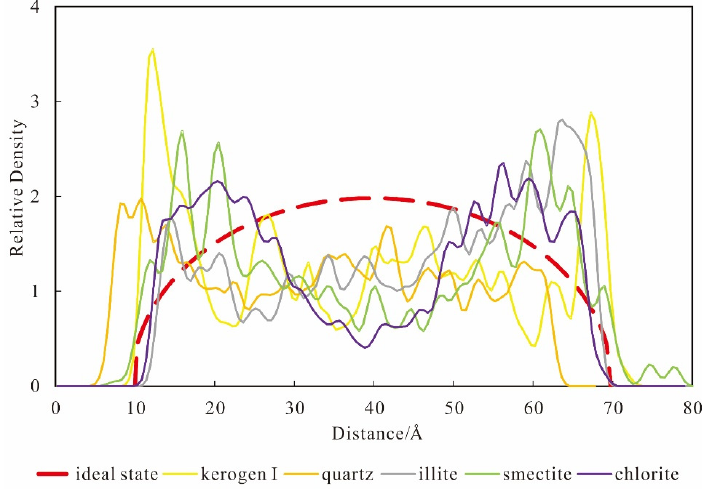
Figure 2. Diagram of relative density of pores in shale with different mineral matrix. Through the calculation of the relative density, the proportions of the excess adsorption amount of several common minerals under the pore diameter of 60 Å diameter, formation temperature of 369.97 K and pressure of 28.07 MPa are obtained, as shown in the Figure 3.